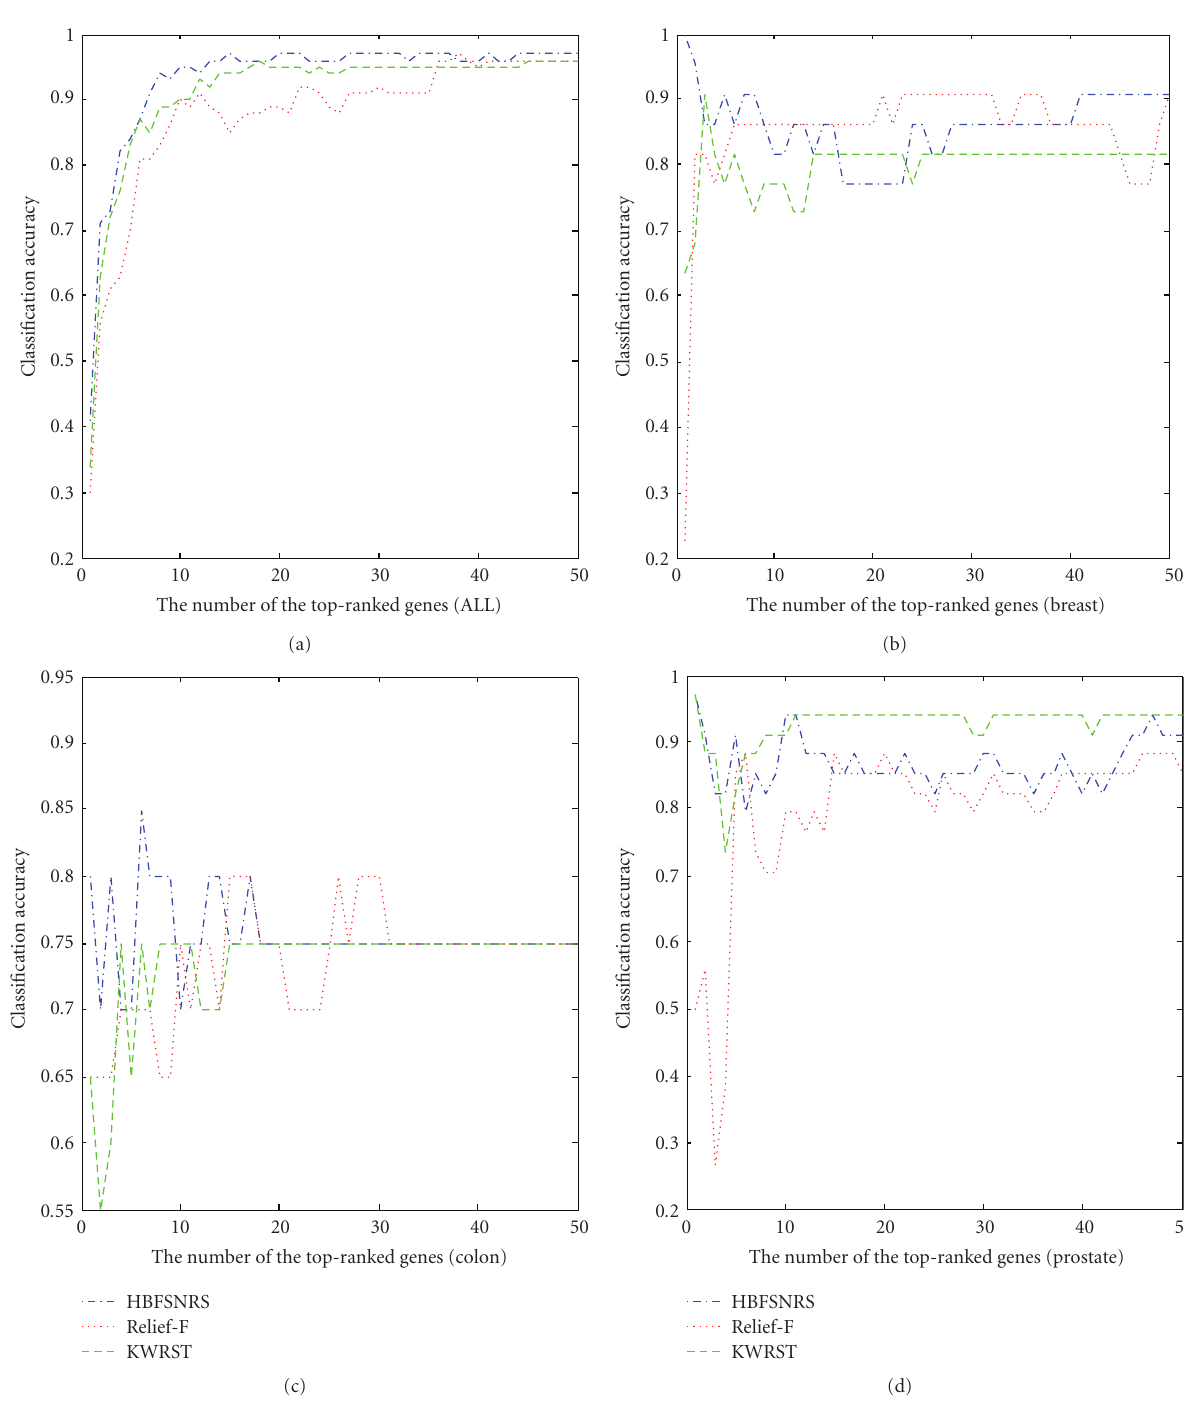
Figure 2: Comparison of classification accuracy with di ff erent numbers of top-ranked genes on the four test datasets by HBFSNRS, Relif-F, and